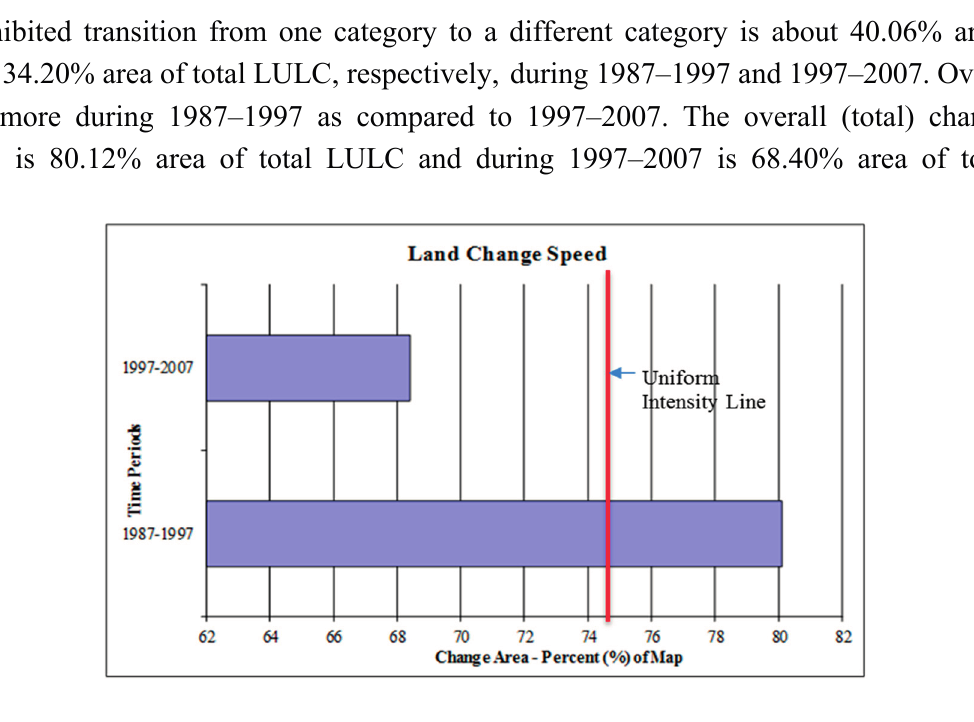
Figure 6. Land change speed (rate of change) in between 1987 and 1997 and 1997 and 2007. A gross gain of one category is always accompanied by a gross loss of another category, so the total gross gain is equivalent to the total gross loss in a landscape, which is 40.06% in 1987–1997 time period and 34.2% in between 1997–2007. Between 1987–1997, degraded forest is the most highest category in terms of total gross gains and gross losses (17.66%), since it accounts for 8.04% points of the total gross gain and for 5.21% points of the total gross losses, followed by agricultural fallow land since it accounts for 3.02% points of the total gross gain and for 9.62% points of the total gross losses and total gain and loss 9.46%. while built up land is the highest gained LULC since it accounts for 10.42% points of the total gross gain and for only 0.30% points of the total gross losses, but there is a high proportion (10.72%) of total gain loss components of change for built up land ,we considered only the net change, the bulk of change in built up land would have been overlooked, which could have led to the wrong conclusion that built up is one of the more dynamic categories after degraded forest. Thus both swap and net changes are important to understand the total change in a landscape. This is in agreement with the finding of Pontius et al . [10] who stated that accounting for only net change could lead to a bias of dramatically underestimating the total change. While the sum of gross gain and gross loss indicates the total change, the difference between the gross gain and gross loss for a category is the net change for the given category. The difference between the total change and net change is the amount of swap change (Tables 11 and 12). Figure 7 shows the intensity of gross gain and gross loss of each LULC category between 1987 and 1997 and Figure 8 shows the intensity of gross gain and gross loss of each LULC category between 1987 and